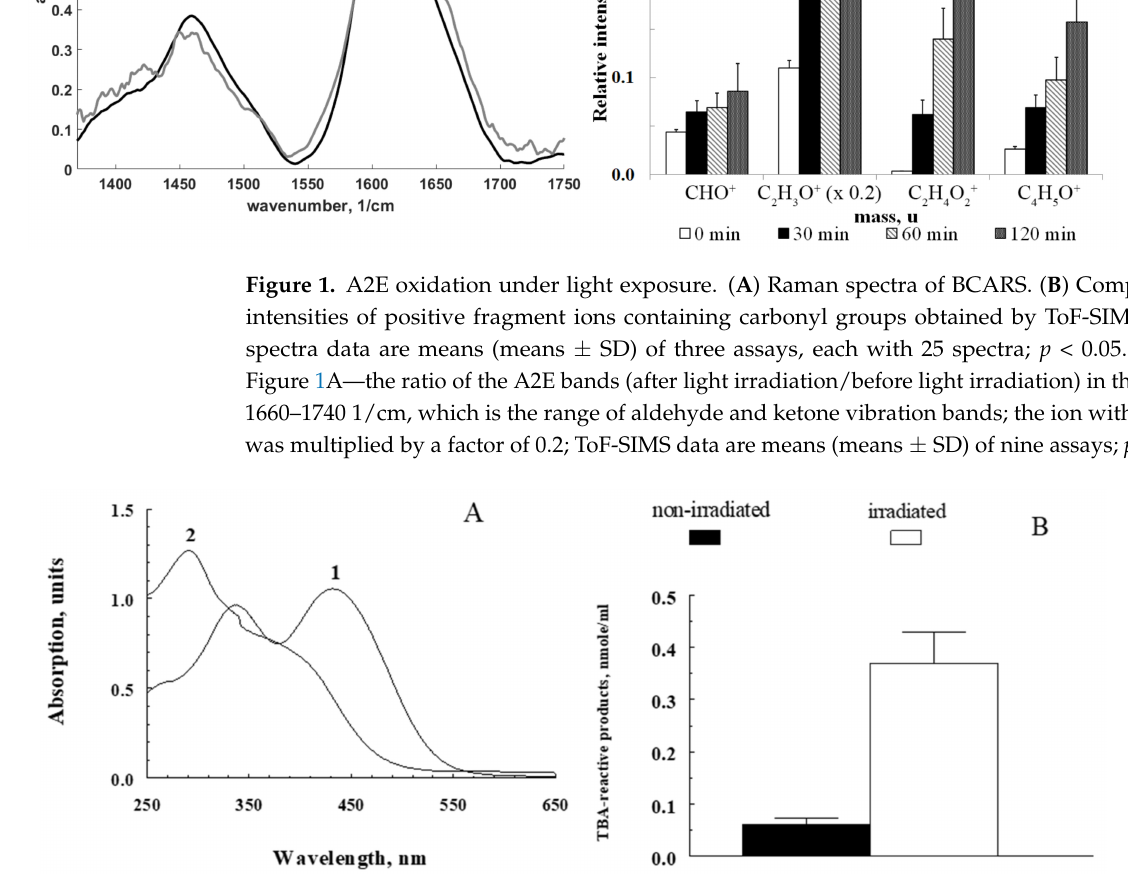
Figure 2. Formation of TBA-reactive products in photooxidation of fluorophore A2E. ( A ) Alteration in spectral characteristics of A2E during photobleaching (1—non-irradiated A2E; 2—irradiated A2E). The reaction medium contained 1mM A2E in a mixture of 0.1 M K-phosphate buffer and methanol (1:3; v : v ). Irradiation was performed with blue light (450 nm) for 90 min. ( B ) Accumulation of TBA- reactive products in water-soluble fractions obtained from non-irradiated and irradiated fluorophore A2E. Data are means (means ± SD) of four assays; p <